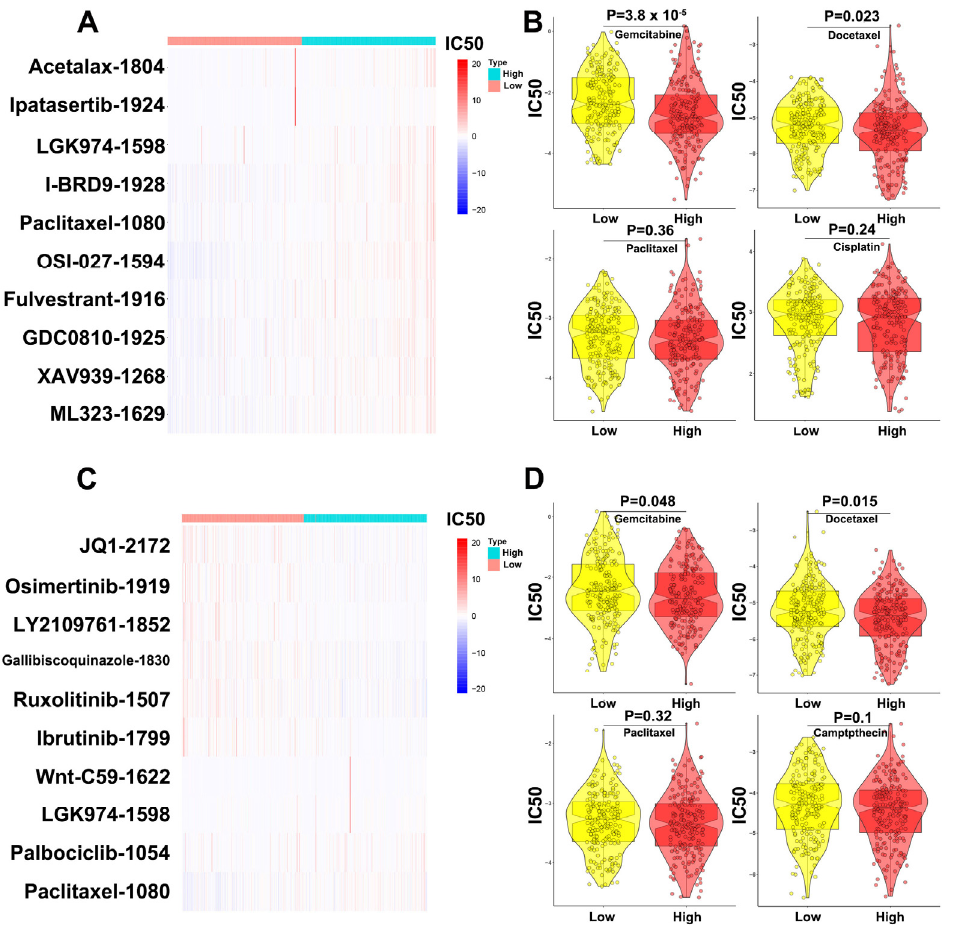
Figure 8. Validation of the effect of MBNL1-AS1 and CDKN1B on drug sensitivity in prostate cancer. ( A ) Prediction of MBNL1-AS1-related sensitive targeted drugs. ( B ) Prediction of MBNL1-AS1-related sensitive chemotherapeutic agents. ( C ) Prediction of CDKN1B-related sensitive targeted drugs. ( D ) Prediction of CDKN1B-related sensitive chemotherapeutic agents.